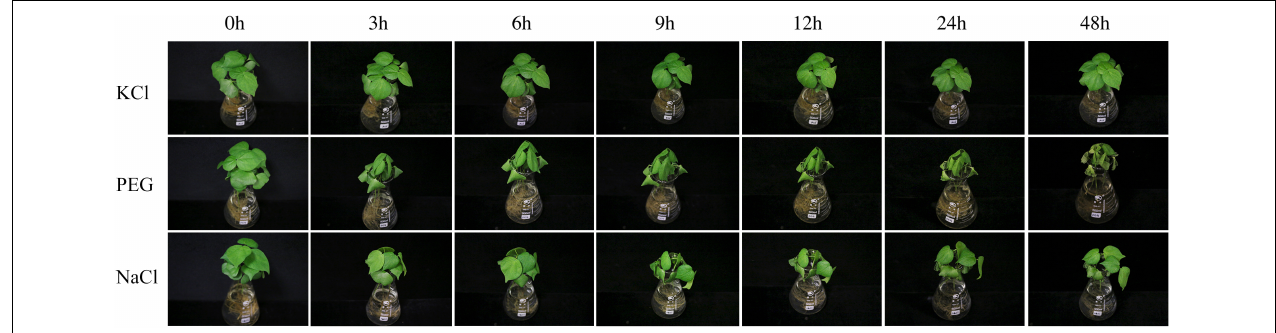
FIGURE 11 | TM-1 phenotypic pictures at different time points (0, 3, 6, 9, 12, 24 and 48 h)after 0.03 mM KCl, 18%PEG and 300 mM NaCl